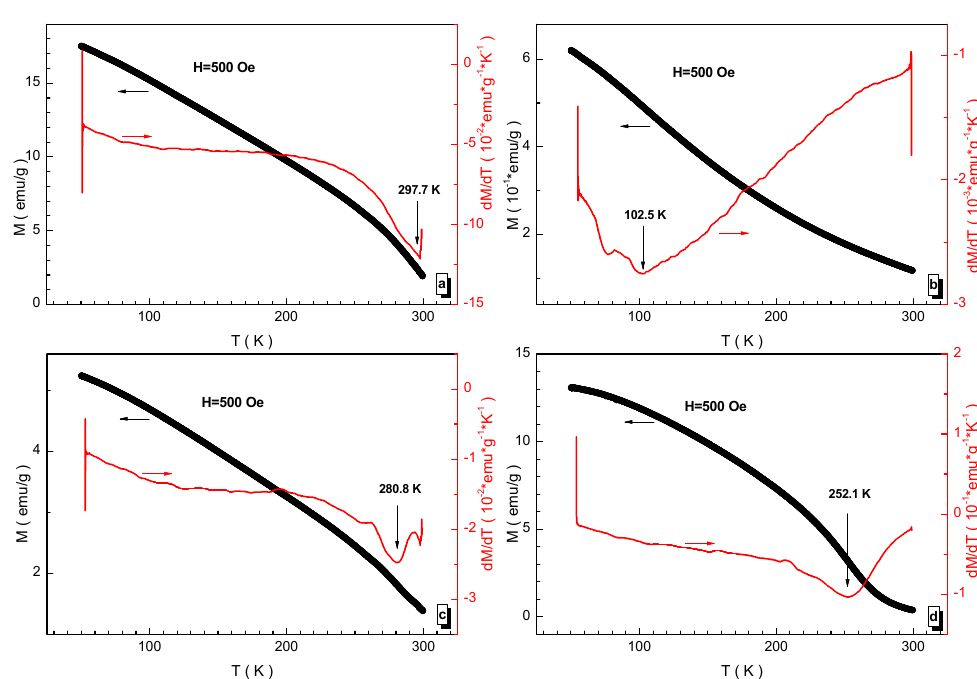
Figure 8. Temperature dependencies of magnetization (black symbols and left axis) in field of 500 Oe and its derivative (red symbols and right axis) for the compositions ( a ) BaFe 5.84 Ga 6.16 O 19 , ( b ) BaFe 6.26 Al 2.27 Cr 3.47 O 19 , ( c ) BaFe 6.11 Al 1.56 Cr 2.17 Ga 2.16 O 19 , ( d ) BaFe 6.19 Al 1.25 Cr 1.57 Ga 1.74 In 1.26 O 19